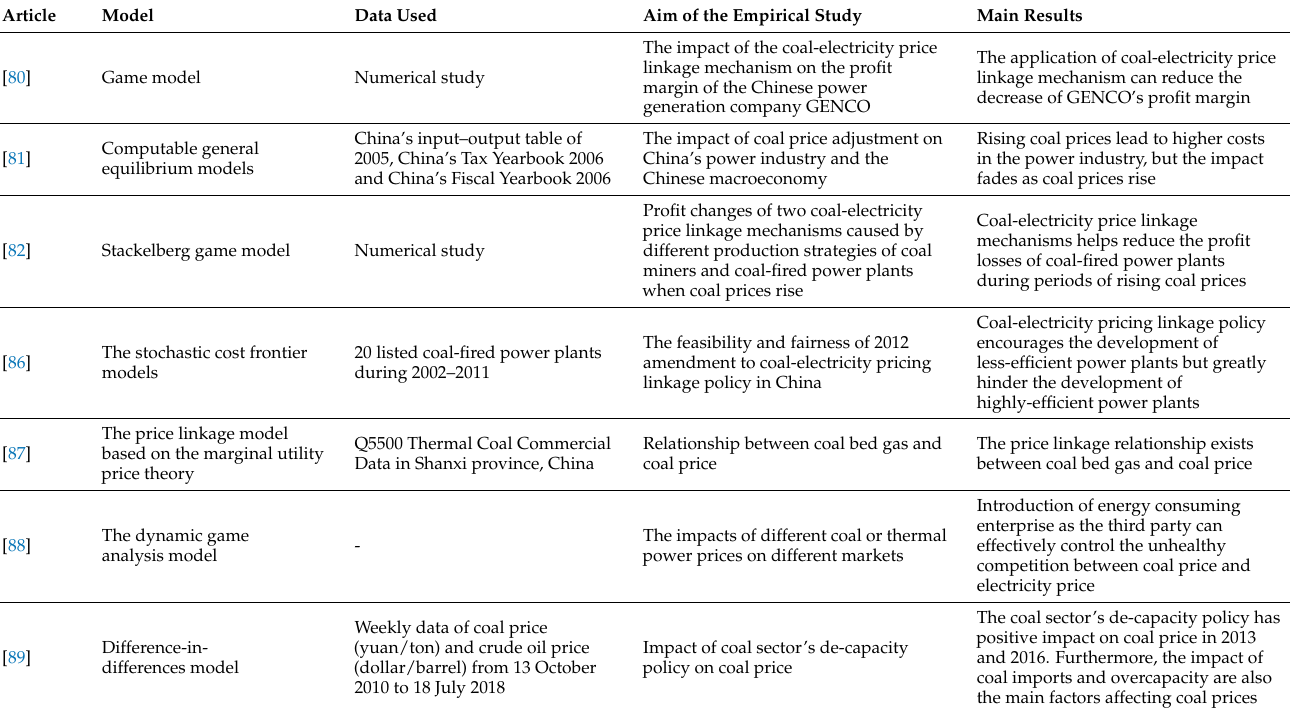
Table 2. The results of empirical studies on coal–electricity price linkage